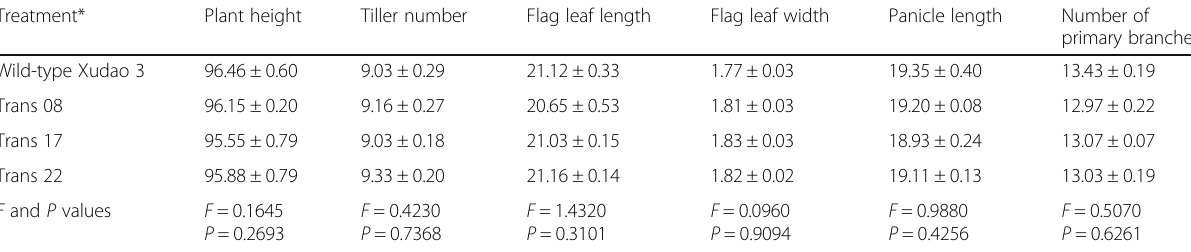
Table 2 Agronomic characteristics of transgenic homozygous lines population